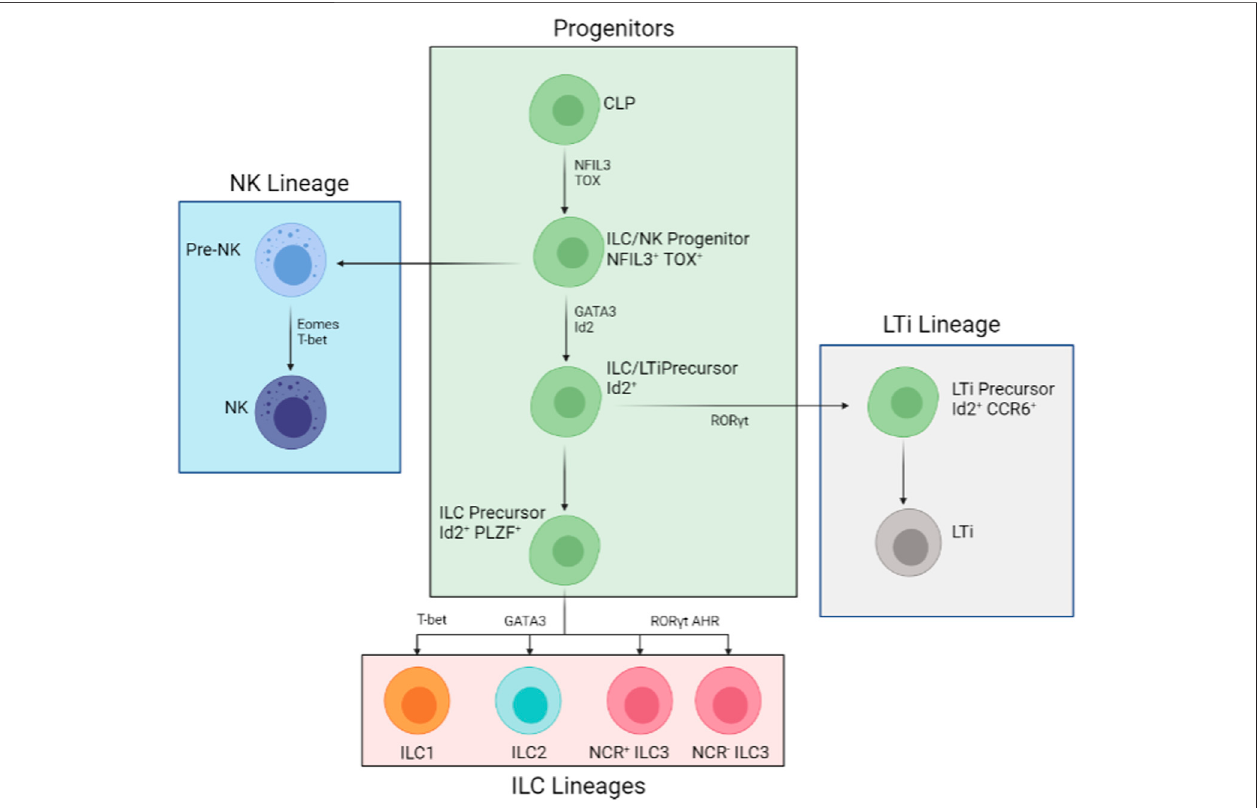
FIGURE 1 | Developmental Process of the ILC Family. All members of the ILC family derive from the common lymphoid progenitor (CLP). The developmental pathwaysaremostlysplitintothreelineages:NKlineage,ILClineage,andLTilineage.TheNKpathway(inblue)isthe fi rsttoderailfromthemainpathways(ingreen).The downstreamprogenitorisanId2+NFIL3+TOX+LTiandILCprecursorandId2+NFIL3+TOX+PLZF+precursorrestrictedtoILCs(inpink).TheLTirestrictedprecursor (ingrey)isanintermediatecellstagethatis,Id2+ROR γ t+CCR6+.FurtherdownfromtherestrictedILC-onlyprecursor,T-bet,GATA3,andROR γ tAHRareneeded for ILC1, ILC2, and all types of ILC3 development